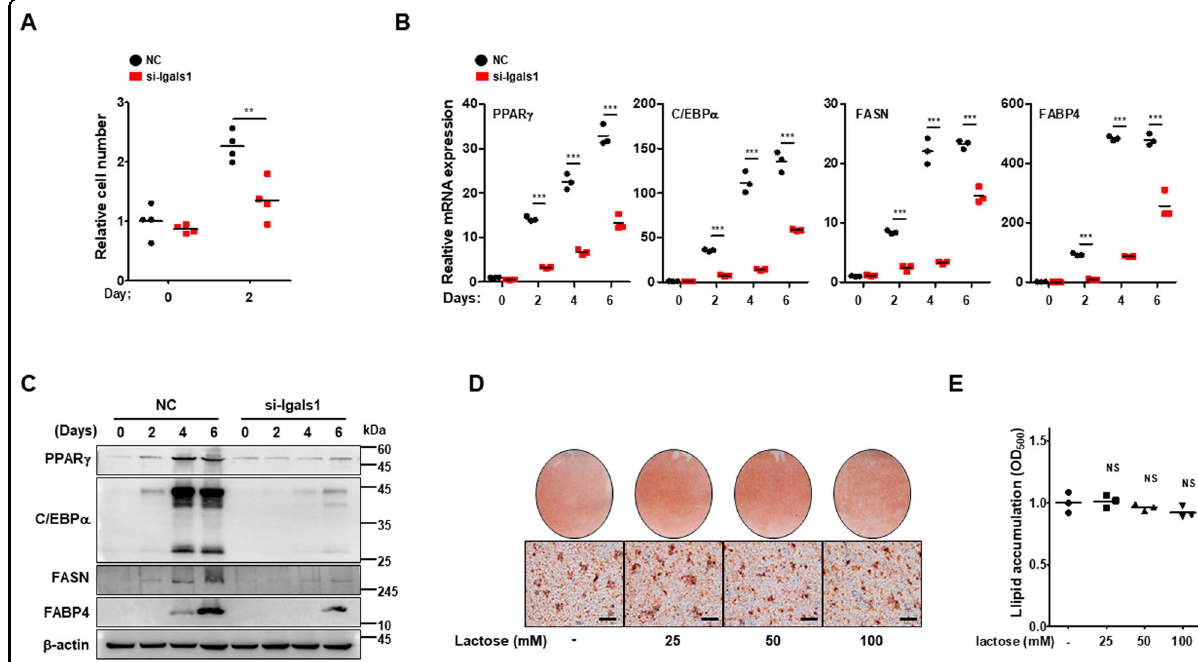
Fig. 2 Galectin-1 knockdown inhibited adipocyte differentiation. a Detection of mitotic clonal expansion during adipocyte differentiation. Cells were counted by viewing with microscopy at 0 and 48 h after inducing adipocyte differentiation. b The mRNA expression level of adipogenic and lipogenic factors, such as PPAR γ , C/EBP α , FASN and FABP4 was analyzed by quantitative RT-PCR in 3T3-L1 cells, with or without galectin-1 silencing. Data are presented as the mean ± SEM ( n = 3 for each lane). *** p < 0.001 for the NC group vs. the Lgals1 siRNA treated group. c The protein expression level of adipogenic and lipogenic factors was analyzed by western blotting in 3T3-L1 cells, with or without galectin-1 silencing. β -actin expression was used as a loading control. d Detection of adipocyte differentiation of 3T3-L1 cells in the absence or presence of lactose (25, 50, or 100 mM). Adipocyte differentiation was induced by treating the cells with DMI and lactose for 6 days. Cell morphology was detected by microscopy. Bars indicated 50 μ m. e Measurement of lipid accumulation. The ORO dye (used for staining) was eluted with 100% isopropanol and the OD 500 was